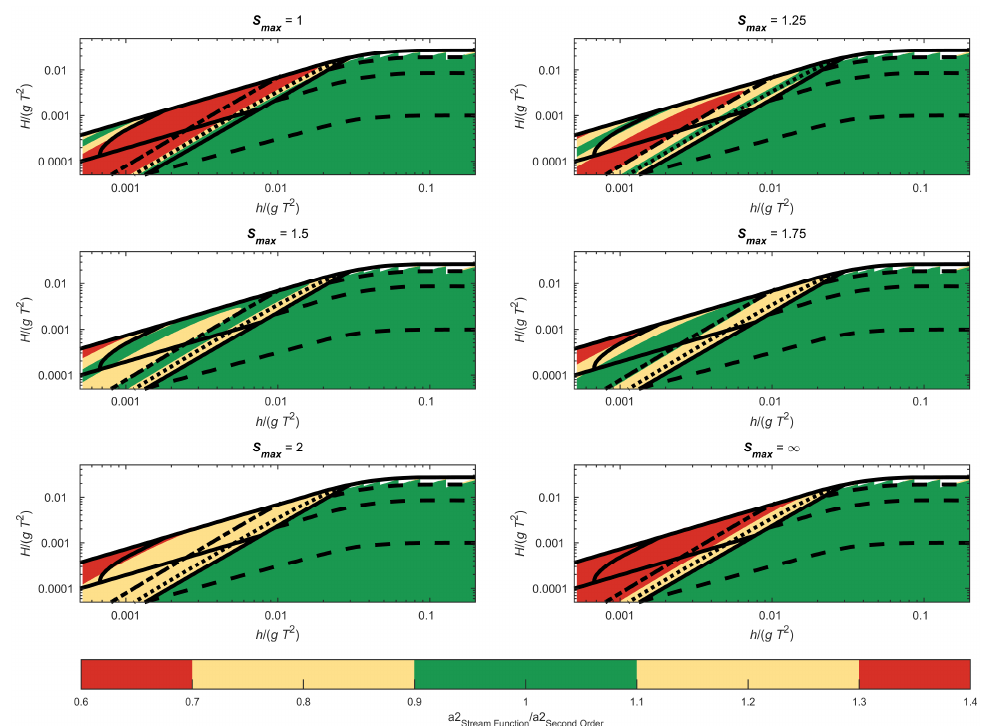
Figure 2. Comparison between the second-order amplitude calculated with second-order and stream function wave theory. S = 1.5 for the dotted line and S = 3 for the dashed-dotted line, which can also be seen in Figure 1 by the colored areas.